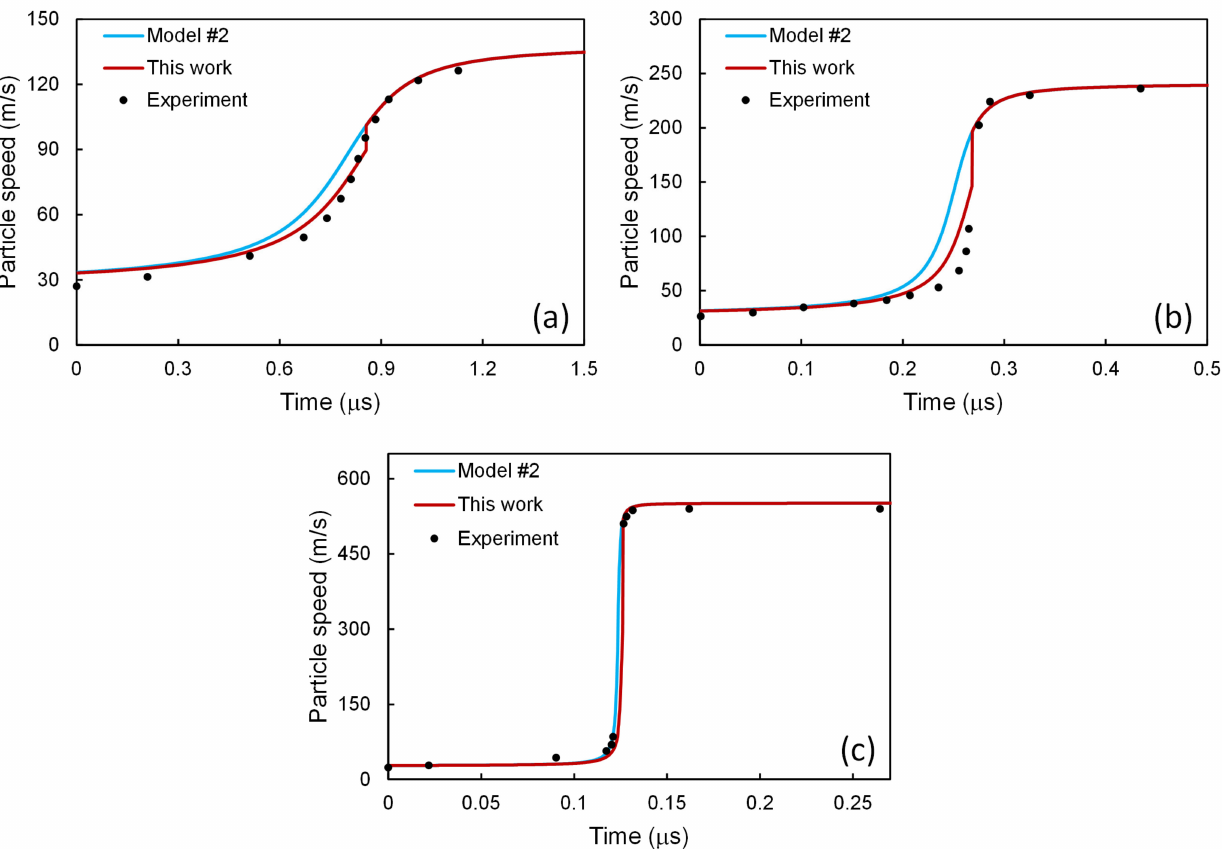
Figure 5. Particle speed profiles for 6061-T6 Al alloy at shock stress amplitudes of ( a ) 2.1, ( b ) 3.7, and ( c ) 9.0 GPa. The present scheme has been applied to model #2 [2,22], and the results are compared with those from model #2 [2,22] and the experimental ones